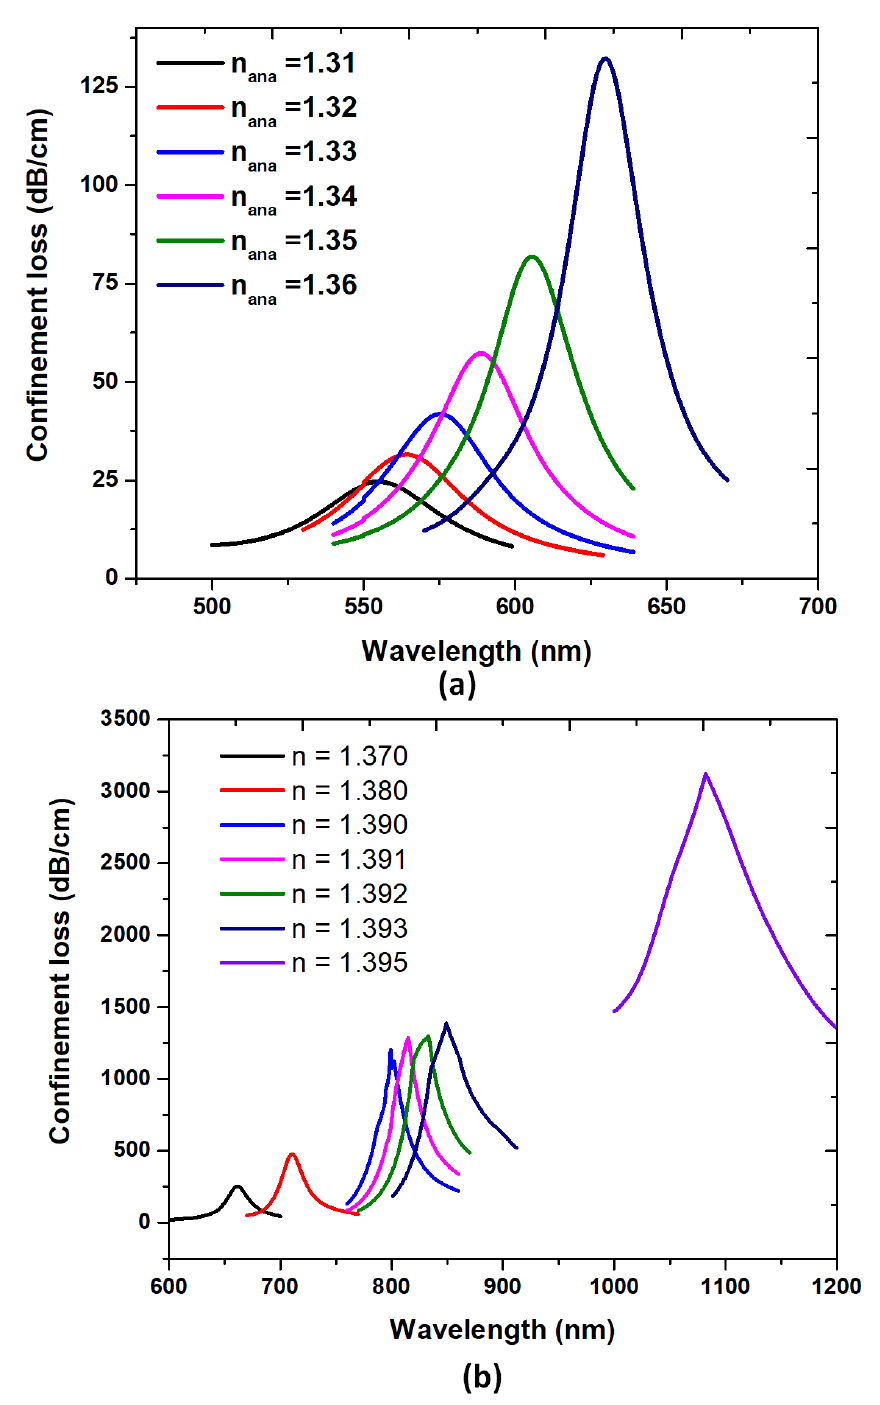
Figure 10. Confinement loss spectra of the core-guided mode for different RIs of analytes ( n ana ), ( a ) n ana = 1.31, 1.32, 1.33, 1.34 and 1.35 and ( b ) n ana = 1.36, 1.37, 1.38, 1.39, 1.391, 1.392, 1.393 and 1.395.